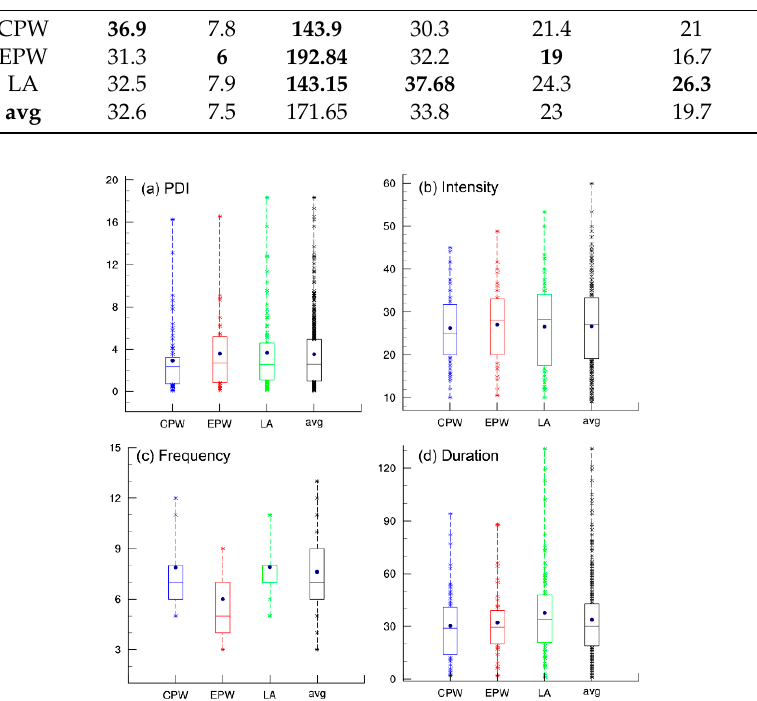
Figure 2. Distribution of ( a ) average PDI (10 5 m 3 /s 3 ), ( b ) intensity (m/s), ( c ) frequency (number), and ( d ) duration (h) of TCs making landfall in CPW, EPW, and La Niña years. “avg” means the total average during period of 1960–2016. The boxes show the 25th and 75th percentiles, the lines in the boxes mark the median, the dark dot mark the mean, and the crosses mark the values below (above) the 25th (75th) percentiles of the distributions.